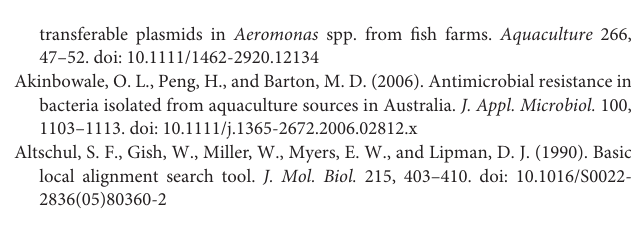
Figure S1 | Assay in a 96-well microtiter plate to detect N -acylhomoserine lactones (AHL) degradation using biosensor strains. Degradation of synthetic AHLs (10 µ M) after 24 h’s incubation was revealed by the suppression of violacein production in Chromobacterium violaceum CV026 (A) and C. violaceum VIR07 (B) . Figure S2 | Detection of remaining AHLs in the culture media using the biosensors Agrobacterium tumefaciens NTL4 (pZLR4), C. violaceum CV026, and C. violaceum VIR07. Upper side of each plate: Cell-free MB medium (control; A) and strain PQQ-42 (B) ; bottom side of each plate: Cell-free MB medium (control; A*) and strain PQQ-42 (B*) after acidification to pH 2. Initial AHL concentration was 10 µ M. Figure S3 | Localization of the quorum quenching (QQ) enzyme in the strain PQQ-42 using the biosensors Agrobacterium tumefaciens NTL4 (pZLR4), C. violaceum CV026, and C. violaceum VIR07. Cell-free MB medium (negative control; A) ; crude cell extracts (B) ; and supernatant (C) of strain PQQ-42. Initial AHL concentration was 10 µ M. Figure S4 | Degradation of AHLs (A), suppression of protease activity (B), and reduction of swimming motility (C) of the pathogenic strain Vibrio mediterranei VibC-Oc-097 (1) when co-cultured for 24 h with strain PQQ-42 (2). Figure S5 | Numbers of V. mediterranei VibC-Oc-097 in